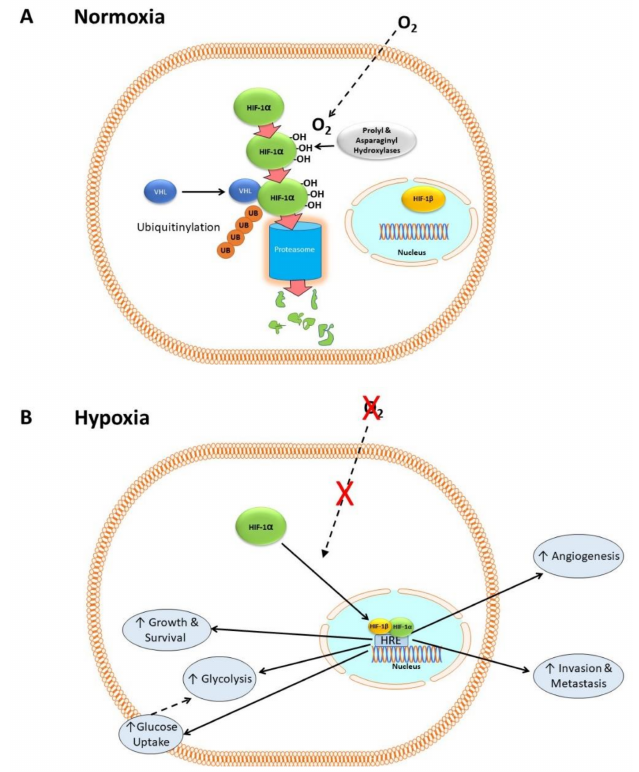
Figure 1. HIF-1 in normoxia and hypoxia. ( A ) In normoxia, HIF-1 α is hydroxylated by prolyl and asparaginyl hydroxylases in the cytoplasm in an oxygen-dependent manner. It then forms a complex with VHL and other proteins, allowing it to be ubiquitnylated and degraded by proteosomes. ( B ) In hypoxia, the lack of oxygen-dependent hydroxylation and proteasomal degradation of HIF-1 α causes it to accumulate. It then translocates to the nucleus and complexes with HIF-1 β to form a transcription factor complex that binds to hypoxia response elements (HRE) within the promoter regions of target genes involved in cell proliferation, metastasis, glycolysis, angiogenesis, growth, and